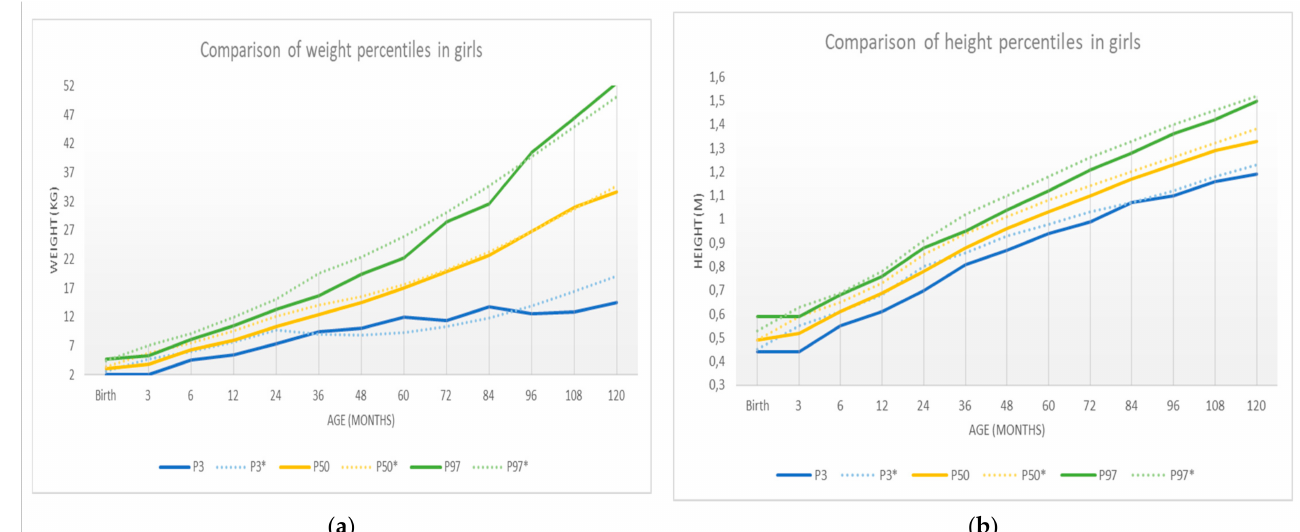
Figure 7. New specific curves for girls (solid) compared to the curves in [8] (dashed): ( a ) weight-specific curves; ( b ) height- specific curves.